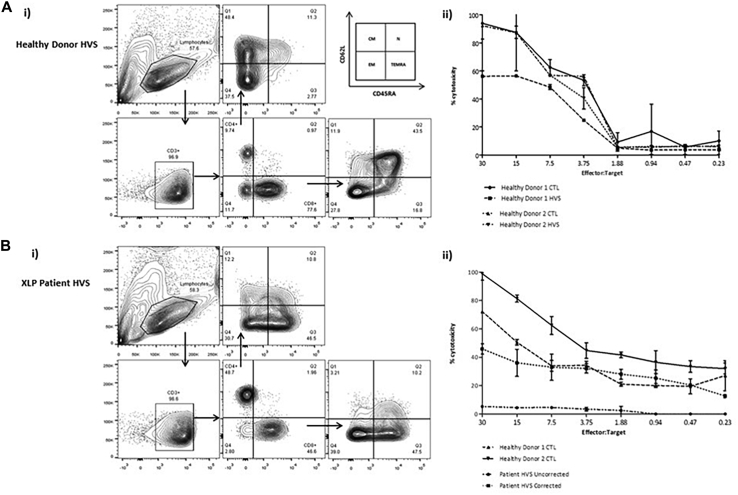
In vitro cytotoxicity of HVS-transformed CTLs by using an allogeneic LCL target. PBMCs from healthy donors and EBV+ patients with XLP were transformed with HVS. Ai and Bi, T-cell memory phenotyping was performed in both CD4 and CD8 populations to determine naive, CD45RA+ effector memory, effector memory, and central memory populations. Patient-transformed samples contained more terminally differentiated cells compared with healthy donors. Aii, 51Cr release assay demonstrated functional activity in HVS-transformed cells from healthy donors by using an allogeneic B-LCL target with no significant difference observed in cytotoxic activity between nontransformed and HVS-transformed cells. Bii, HVS-transformed cells from patients were transduced with the EFS-SAP-eGFP or EFS-eGFP mock vectors and subjected to a 51Cr release assay. Uncorrected patient samples showed no cytotoxic activity against allogeneic B-LCLs compared with patient-corrected CTLs, which were able to kill the LCL target within the range of 40% to 50%. No significant differences were observed between nontransformed healthy donor CTLs and patient-corrected HVS cells in cytotoxic activity when using an allogeneic B-LCL target.